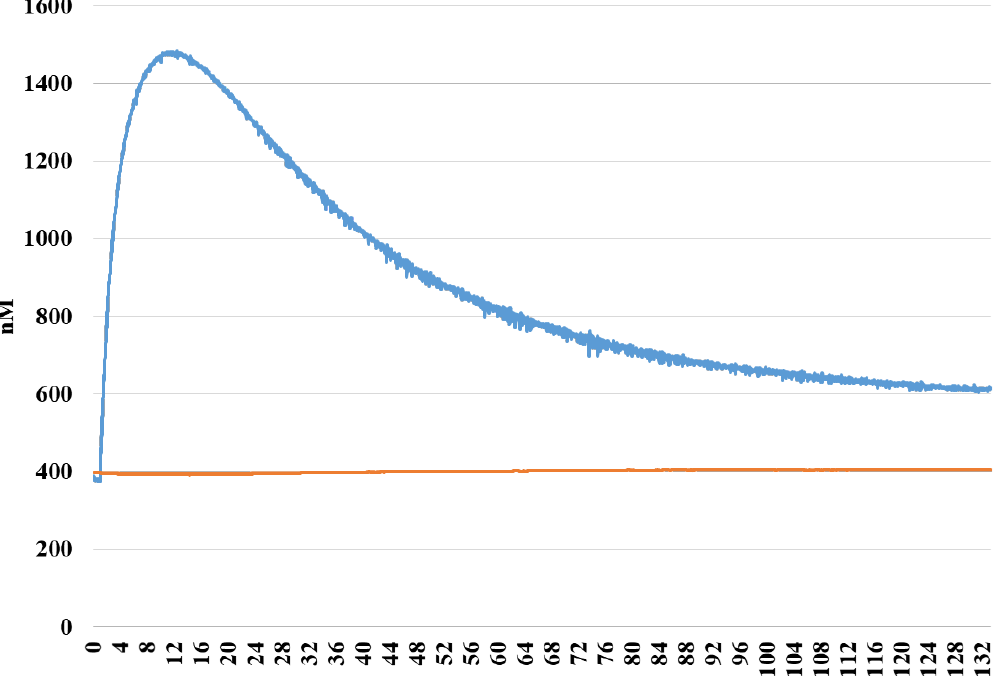
Figure 3. H 2 S-releasing of EV-34: Alteration in H 2 S concentration in media obtained from cells after 3 days of incubation. Blue: EV-34, orange: 1% DMSO.